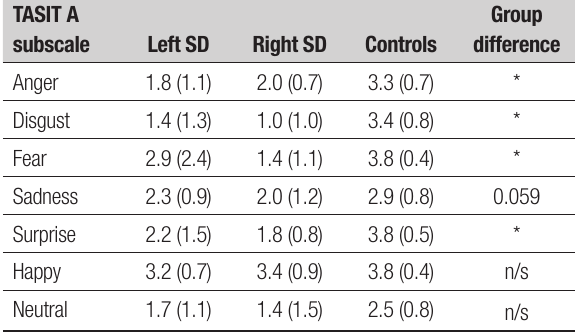
Table 2. Performance of left and right SD cases and controls on subscales of the TASIT emotion recognition task.